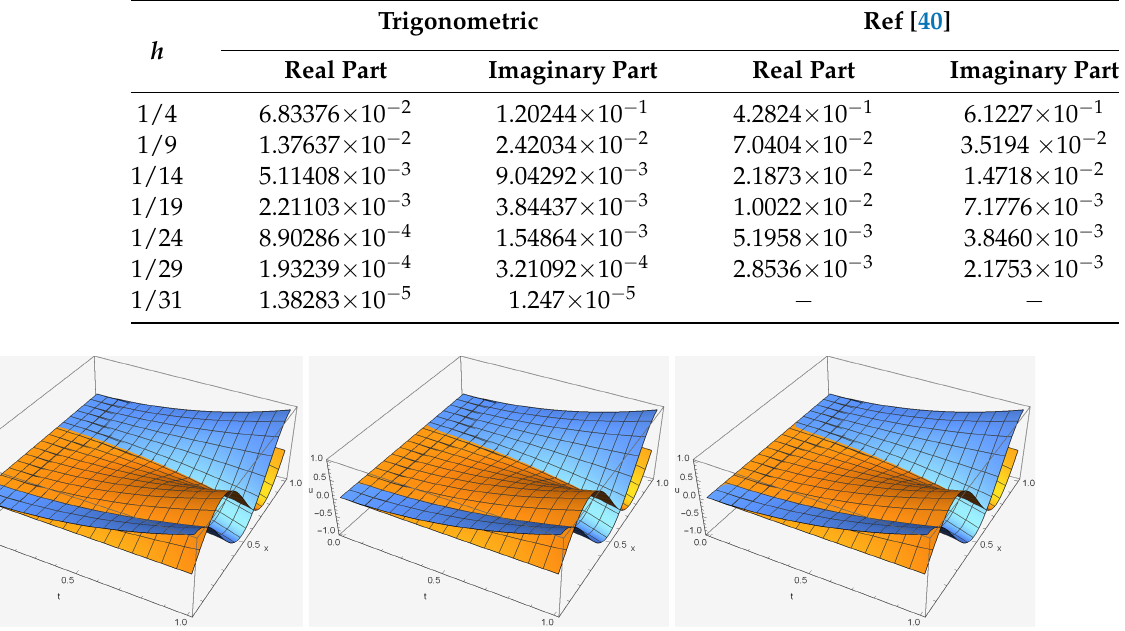
Figure 1. The computed approximation solutions of R and S in Equation (1) for α = 0.9, α = 0.5, α = 0.1, respectively, τ = 0.002, a = 0, b = 1, N = 40 and t =